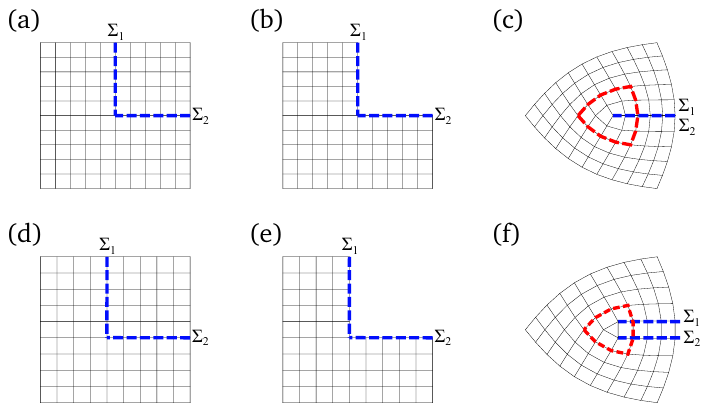
Figure 1: Volterra processes to construct two different π/ 2 disclinations in a C symmetric lattice. The solid lines outline the boundary of the primitive unit cell. (a)- (c) Type-0 disclination centered at a 3-vertex. (d)-(f) Type-1 disclination centered at a triangular cell. The red dashed lines in (c) and (f) indicate paths encircling the respective